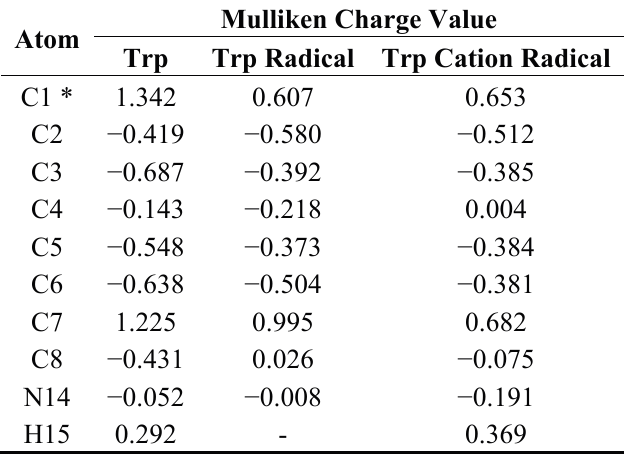
Table 4. The Mulliken charge distribution in Trp and corresponding radical and cation radical.